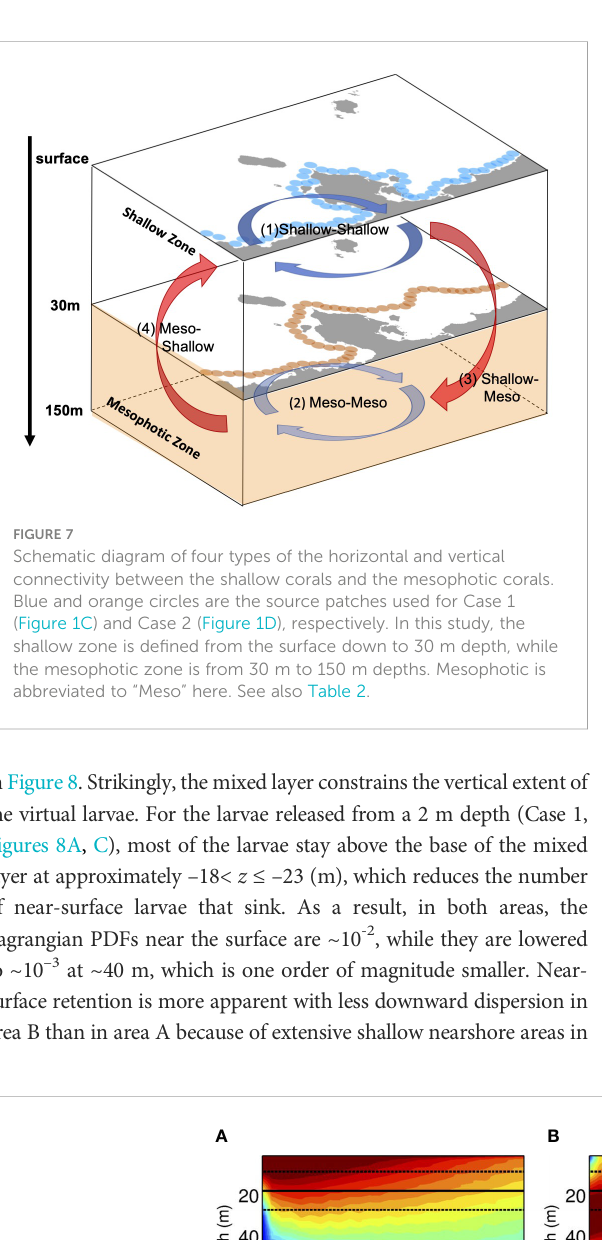
FIGURE 8 Hovmöller plots of the vertical distribution of the Lagrangian PDFs integrated over (A, B) area A and (C, D) area B (see Figure 6C for the de fi nition) as a function of the advection time until T a = 14 days (colors). Left panels (A , C) : Case 1 with shallow releases from a depth of 2 m. Right panels (B , D) : Case 2 with mesophotic releases from a depth of 30 m. The solid black lines indicate the mean surface mixed-layer depth H bls averaged temporally for 1 month of June 2013 and spatially over each area A and B (see Figure 6C), and the dotted black lines indicate the ranges of their standard deviations, ± s .